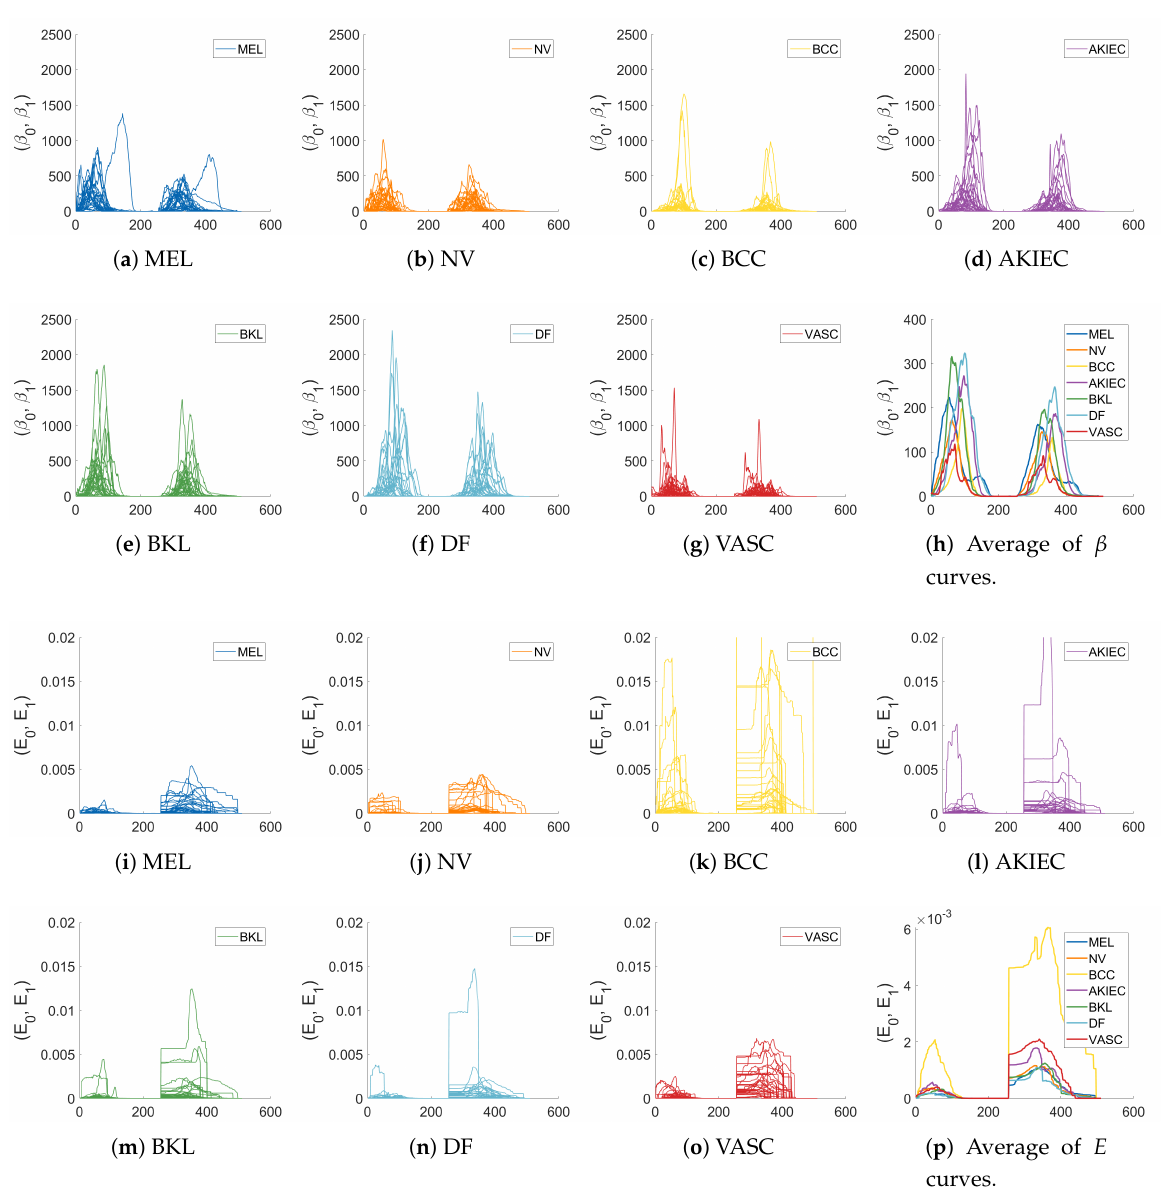
Figure 5. Sample PCs from X channel of XYZ color space of images from different classes. For each class, 30 images are selected at random to illustrate their persistence curves. ( a – g ) Betti number curves, β 0 ( t ) and β 1 ( t ) , for each class. When t ∈ [ 0,255 ] , β 0 ( t ) is shown; when t ∈ [ 256,512 ] , β 1 ( t ) is shown. ( h ) Average of β curves over those 30 images. ( i – o ) Entropy curves, E 0 ( t ) and E 1 ( t ) , for each class. When t ∈ [ 0,255 ] , E 0 ( t ) is shown; when t ∈ [ 256,512 ] , E 1 ( t ) is shown. ( p ) Average of E curves over those 30 images. In our earlier work [32], a support vector machine model was built based on these curves and the classification score was